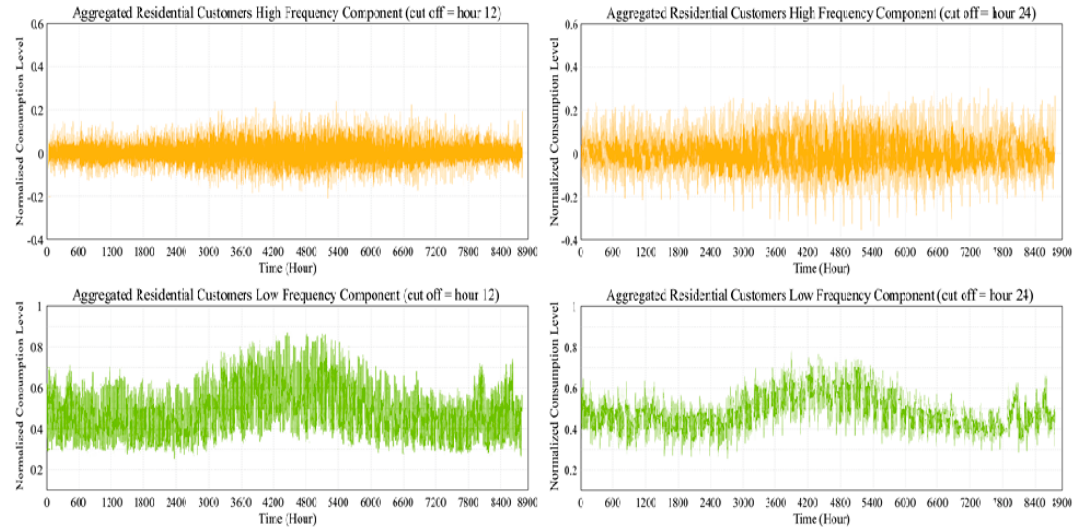
Figure 2. Time-domain electricity consumption signals for aggregated residential customers.